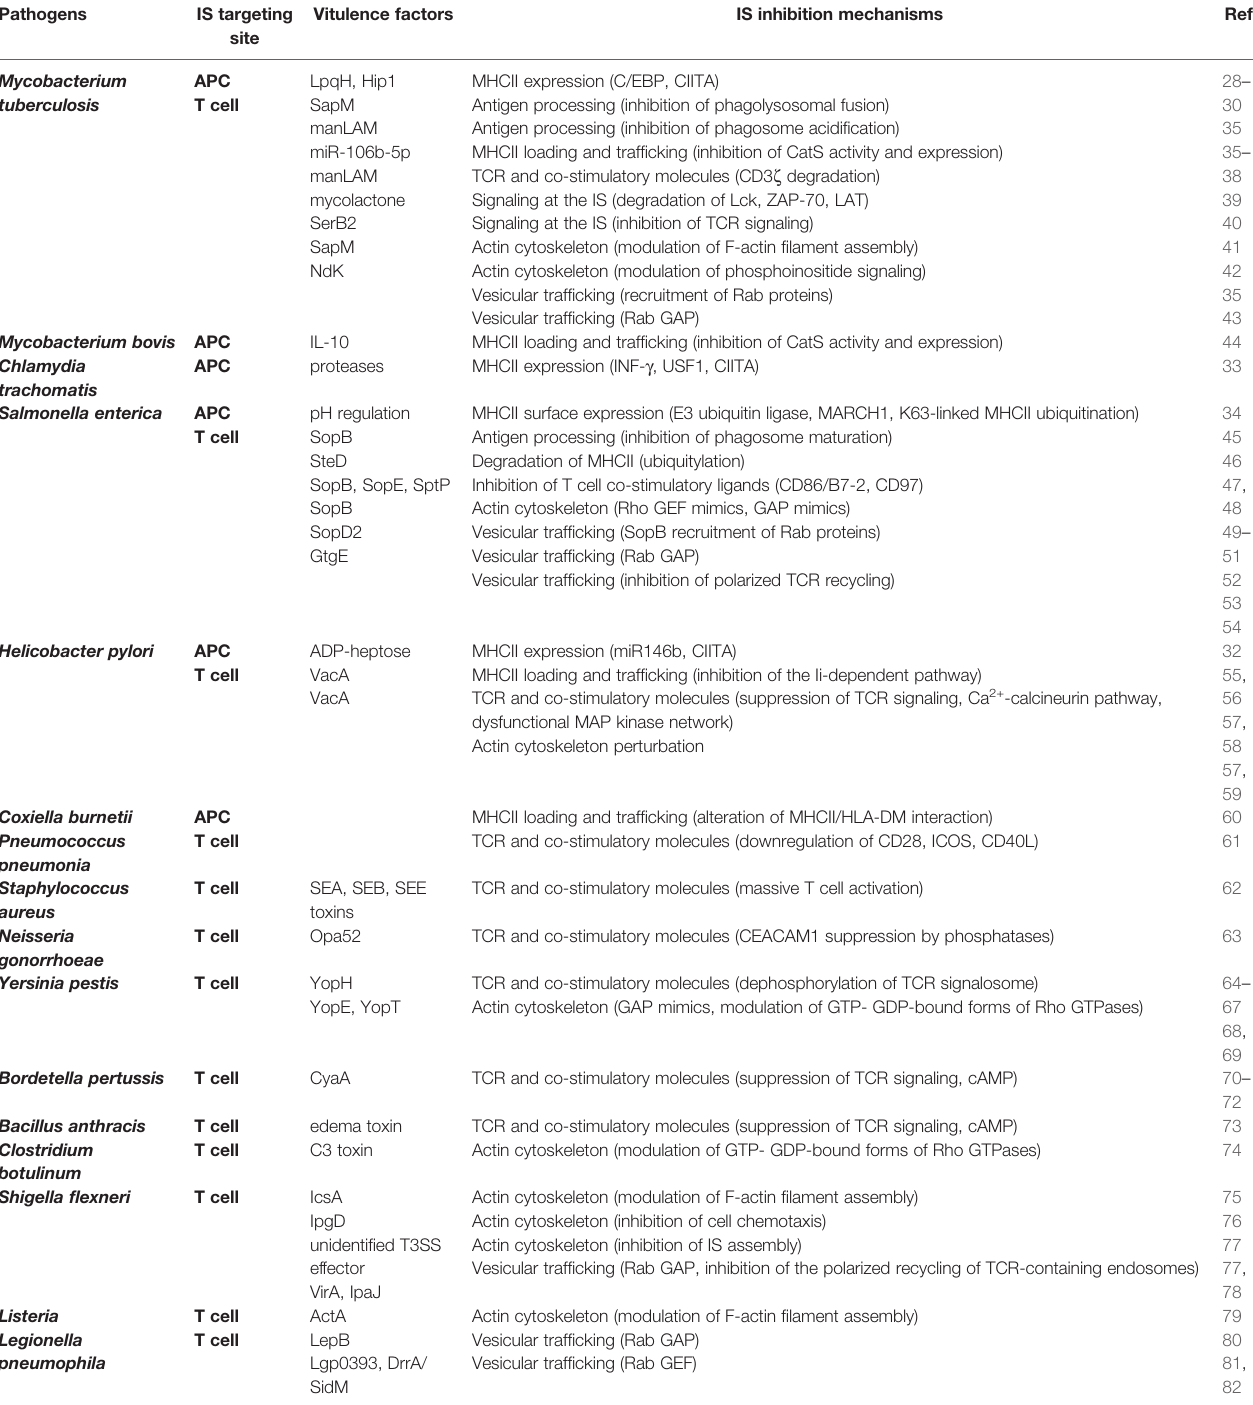
TABLE 1 | Bacterial virulence factors that target directly or indirectly IS